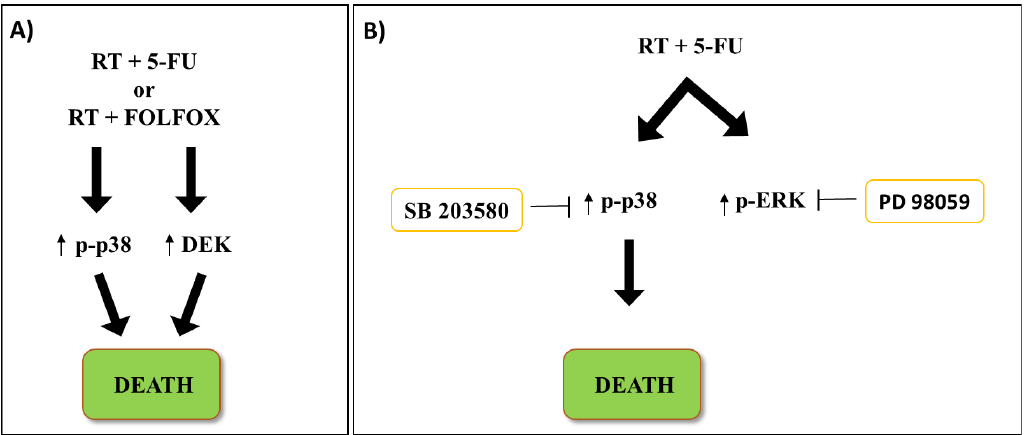
Figure 2. Radiotherapy (RT) in rectal cancer. ( A ) RT treatments revealed strong correlation of increased p38 MAPK and DEK levels with better therapeutic response when combined with 5-FU or FOLFOX in CRC patients. ( B ) RT combined with 5-FU treatment increases both p38 MAPK and ERK phosphorylated proteins levels. The p38 MAPK inhibition (SB203580) promotes cell survival, whereas ERK inhibition (PD98059) did not change treatment-related effects. Up arrows show levels of proteins activation; down arrows show workflow of cell signaling; T bars represent inhibitory actions via chemicals.